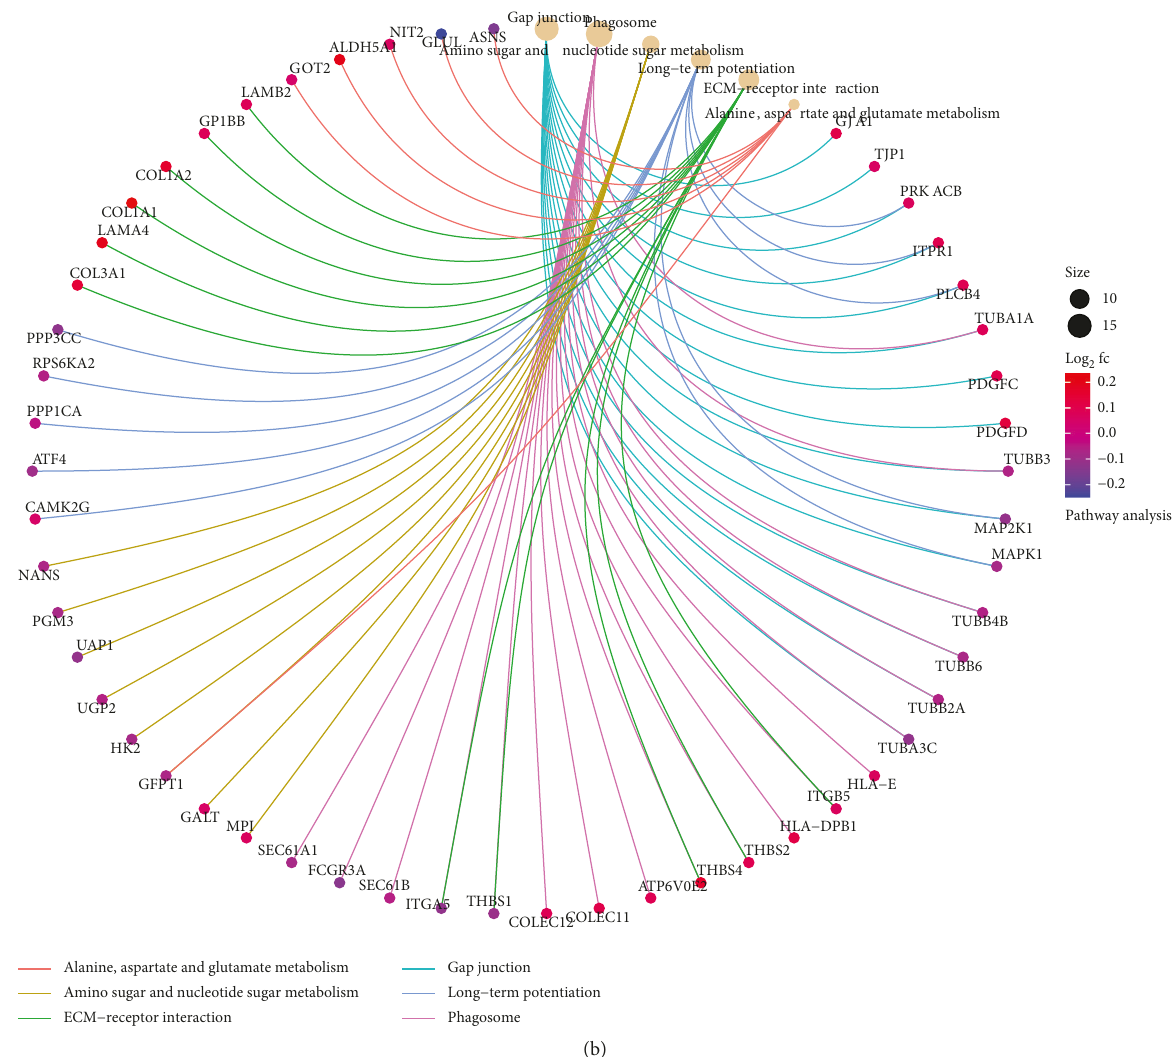
Figure 2: GO and KEGG pathway enrichment analysis. (a) GO enrichment analysis (dots represent genes). (b) KEGG pathway enrichment